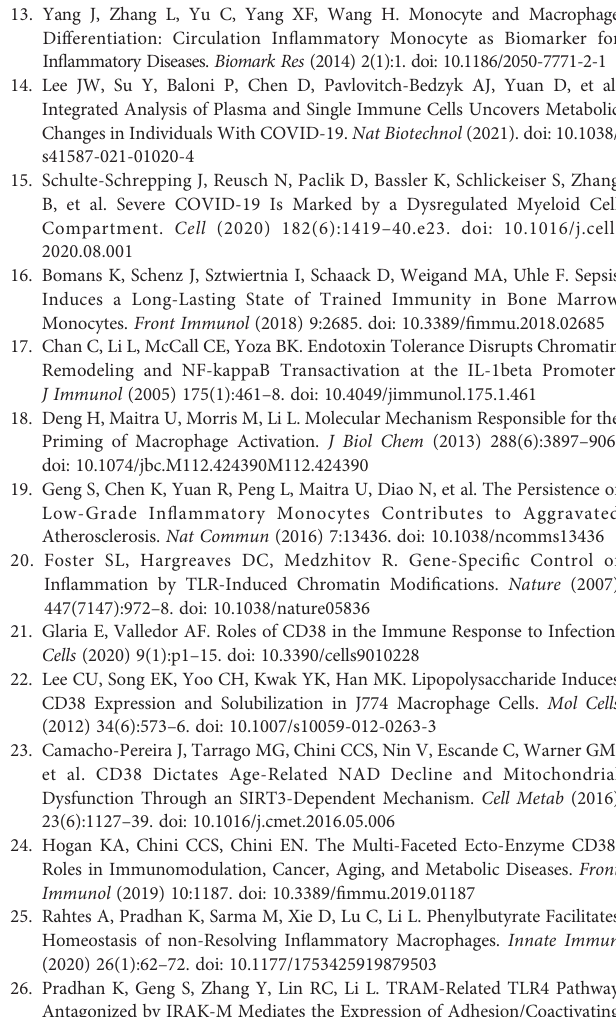
Supplementary Figure 1 | Representative histograms of monocyte tolerant and exhaustion markers. BMDMs from WT mice were treated with PBS or high dose LPS (100ng/mL) for 5 days. (A – D) Representative histograms illustrating shifts in surface MFIs of CD86 (A) , MHCII (B) , PD-L1 (C) and CD38 (D) in live cells obtained via fl ow cytometry were presented. Supplementary Figure 2 | Ly6C + and Ly6C ++ monocyte populations show exhausted phenotypes. BMDMs from WT mice were treated with PBS or high dose LPS(100ng/mL)for5days. (A – D) SurfaceexpressionsofCD86 (A) ,MHCII (B) ,PD- L1 (C) and CD38 (D) within the Ly6C + CD11b + population were determined with fl ow cytometry. (E – H) Similarly, expressions of CD86 (E) , MHCII (F) , PD-L1 (G) and CD38 (H) within the Ly6C ++ CD11b + population were determined with fl ow cytometry. The data are representative of at least three independent experiments, and error bars represent means ± SEM (n=3 for each group). ***p < 0.0001, Student ’ s t